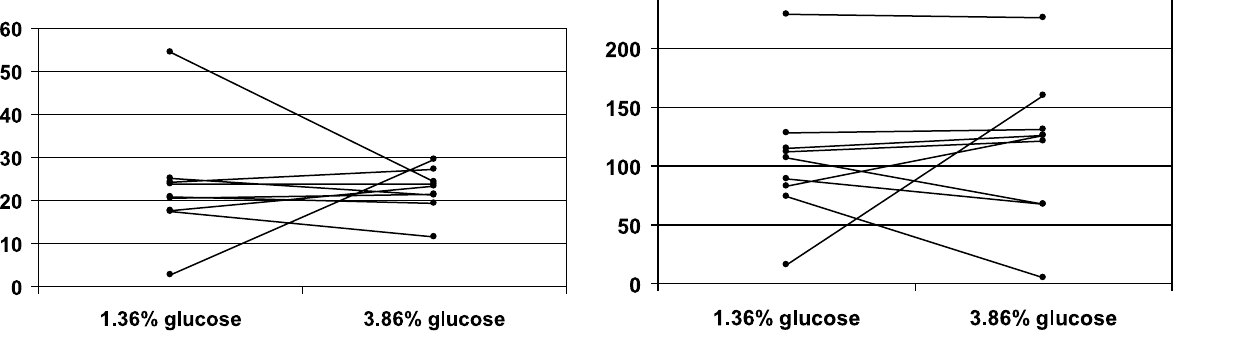
FIG. 1. TNF- a levels after 1.36% and 3.86% glucose used dwells for each patient.